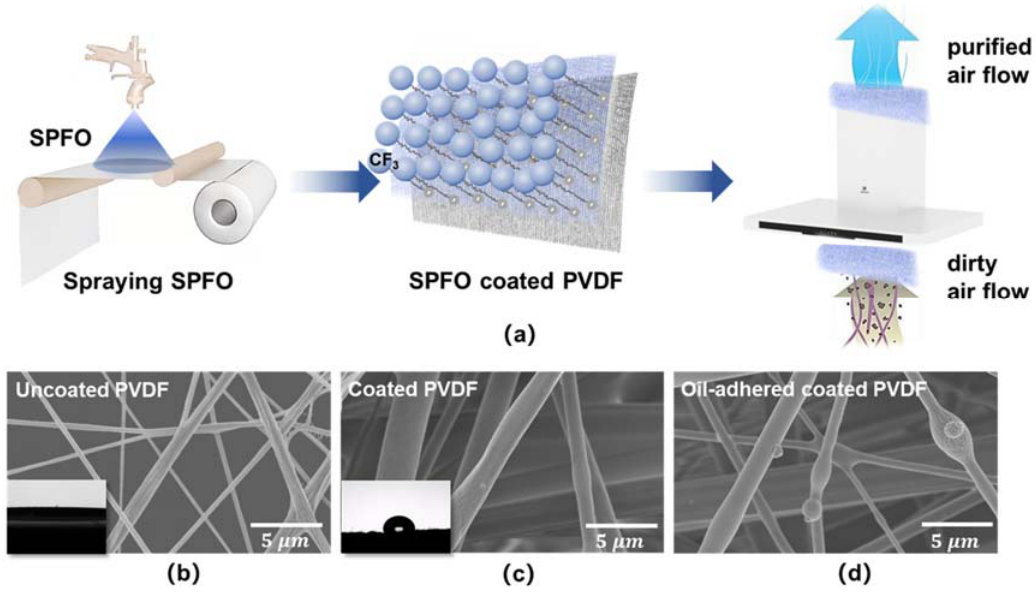
Figure 1. The fabrication process and morphologies of the SPFO oleophobic coating: ( a ) schematic diagram of fabrication of SPFO-coated PVDF; ( b , c ) SEM image of uncoated and SPFO-coated PVDF fibre membranes; inserted images are of oil contact angles; ( d ) SEM image of oil-adhered SPFO-coated PVDF fibre membrane.